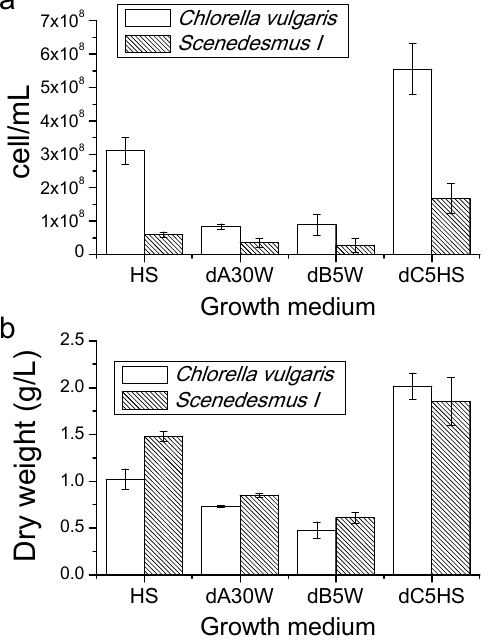
Figure 2. Cell density and dry weight recovered from algae cultures: ( a ) cell density expressed as number of cells per mL; and ( b ) dry weight expressed as g/L.